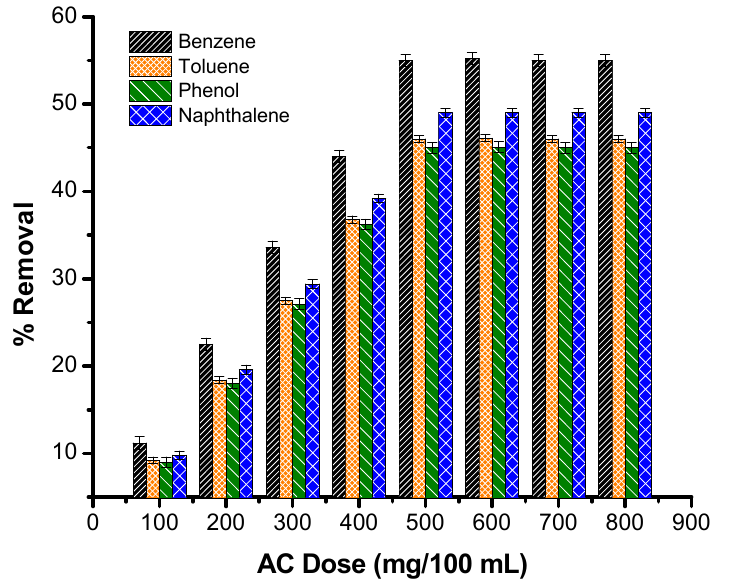
Figure 4. Effect of AC dosage on the removal of HCs from model wastewater (ambient temperature, 60 min, feed volume 100 mL).